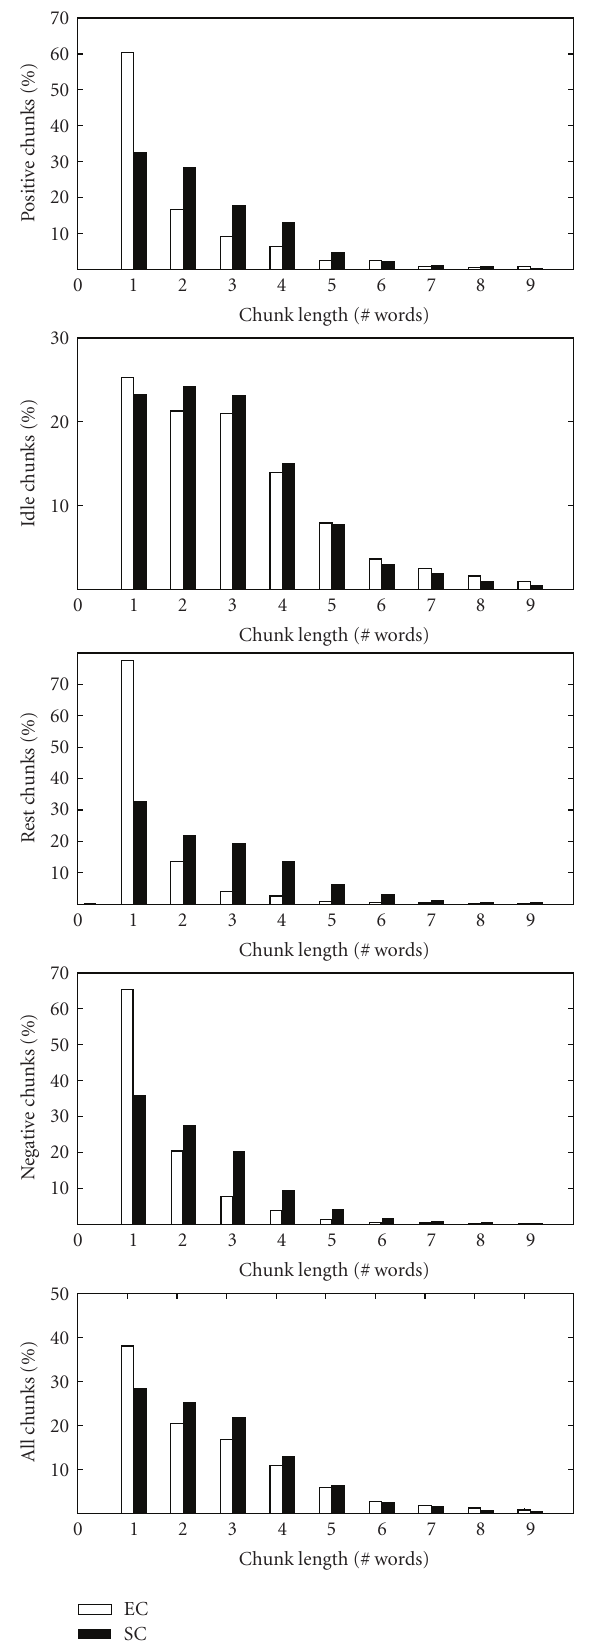
Figure 1: Chunk histogram with frequencies.